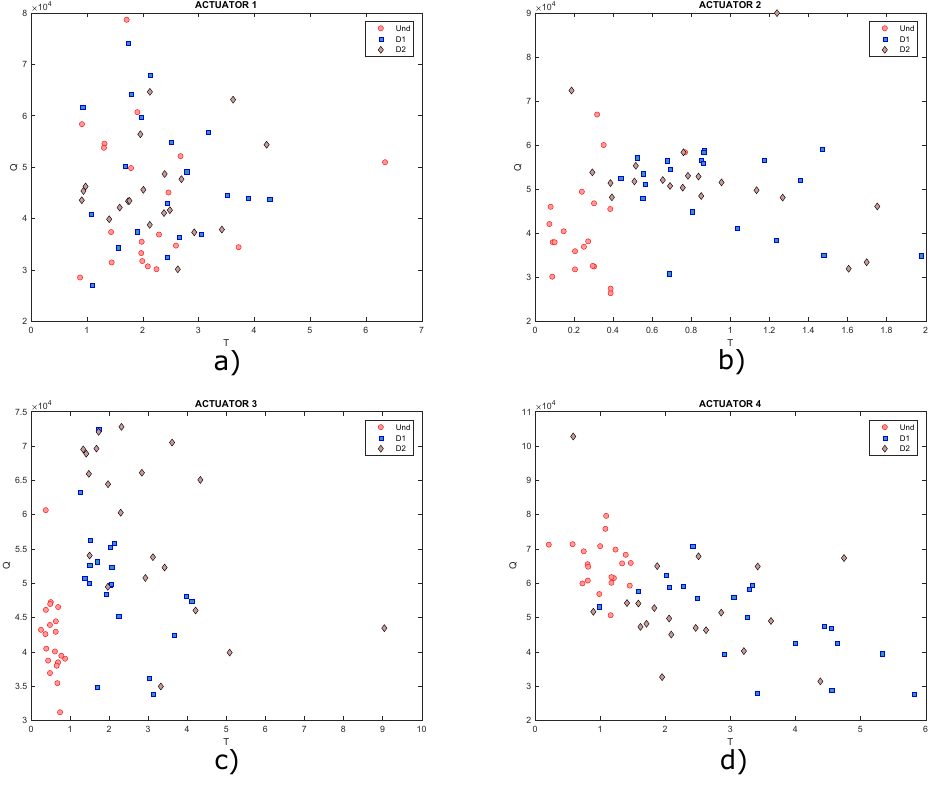
Figure 18. Graphs of T 2 vs. Q for actuation phases: ( a ) 1; ( b ) 2; ( c ) 3 and ( d )